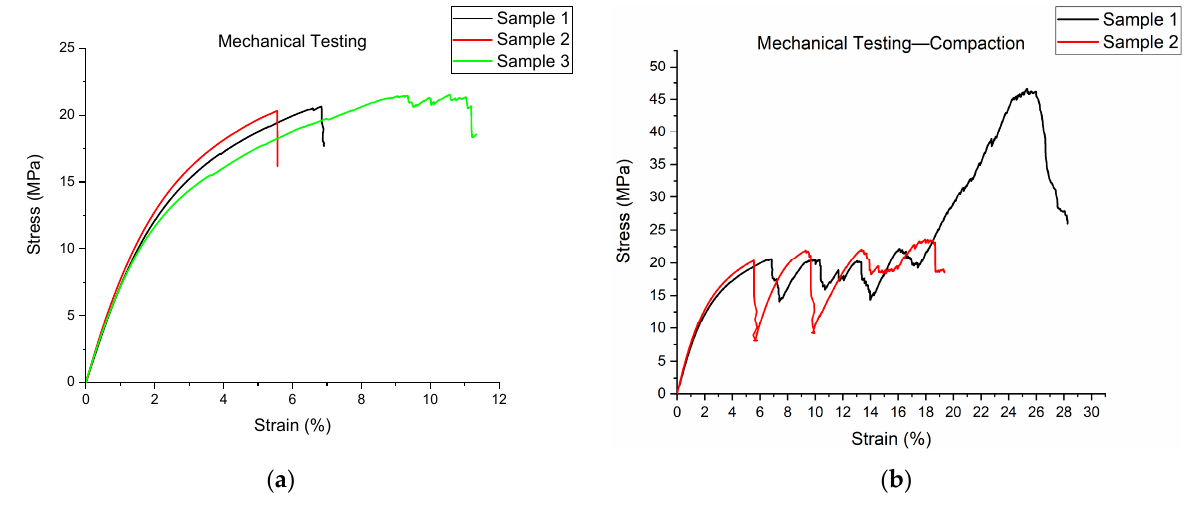
Figure 9. Mechanical compression test results: ( a ) Stress–strain curves for three samples plotted before initial failure; ( b ) Stress–strain curves for two samples plotted during compaction. Table 2. Mechanical properties of lattice structure samples.